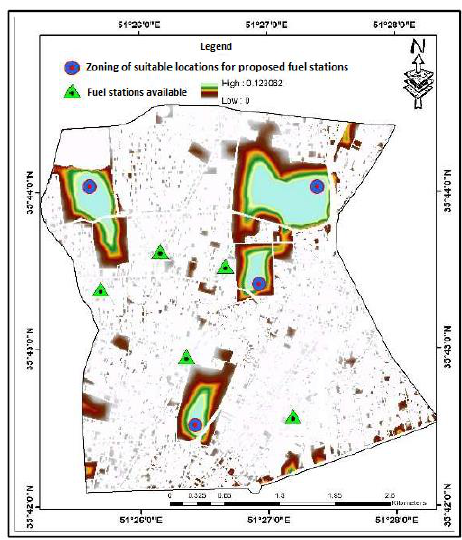
Figure 11. Zoning map of suitable places for fuel